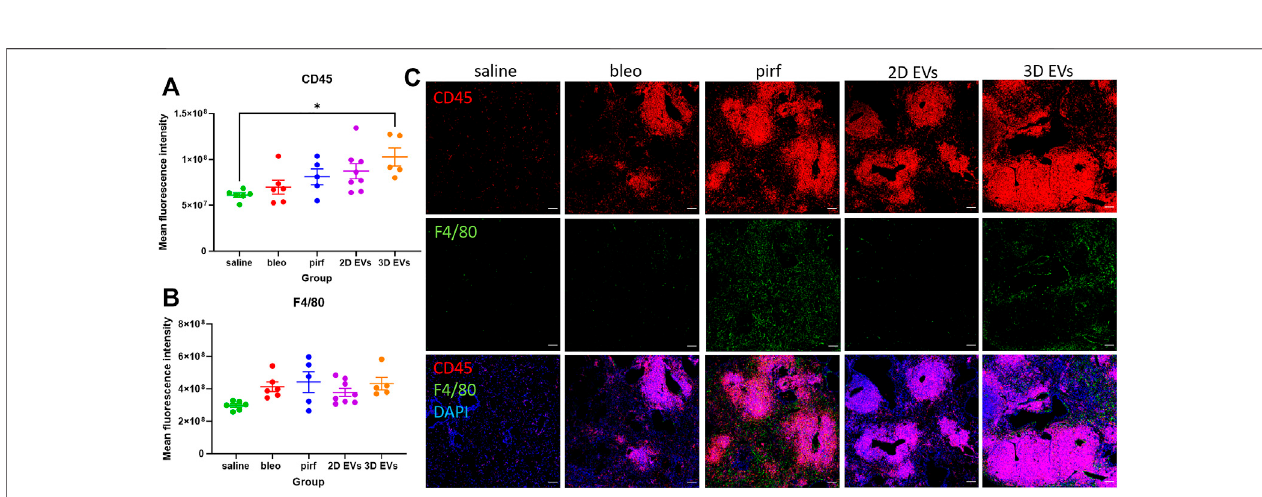
FIGURE8| Representativeimmuno fl uorescenceimagesofCD45(red)andF4/80(green)staininginlungtissuesatD28. (A) Mean fl uorescenceintensityforCD45. (B) Mean fl uorescence intensity for F4/80. (C) Nuclei staining performed with DAPI (blue). The area with DAPI clusters demonstrated the presence of in fl ammatory and fi broblastic in fi ltrate of the lung. Data represent mean ± SEM, n = 5-8 per experimental group; each symbol represents 1 animal, one-way ANOVA followed by Tukey ’ s post hoc test for multiple comparisons, * p < 0.05. Scale bar is 100 µm.